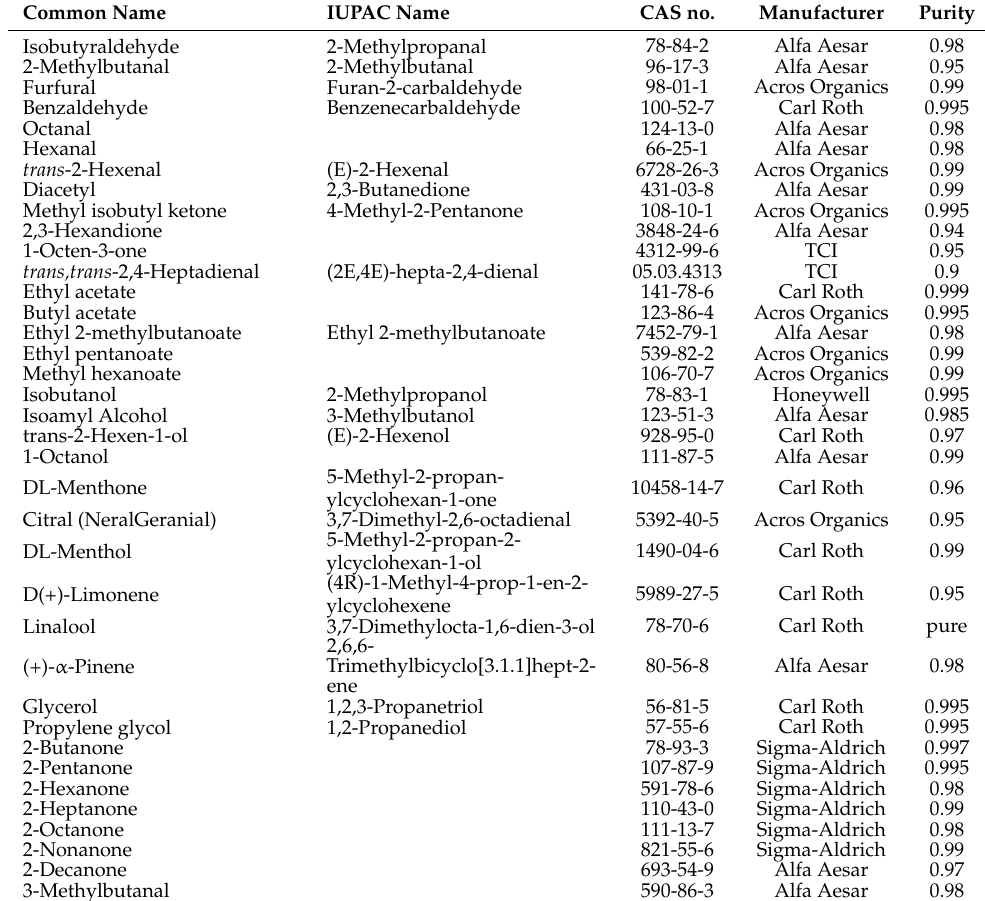
Table A1. Listof substances that were identified and or used in this publication and the manufacturers of reference standards, when those were